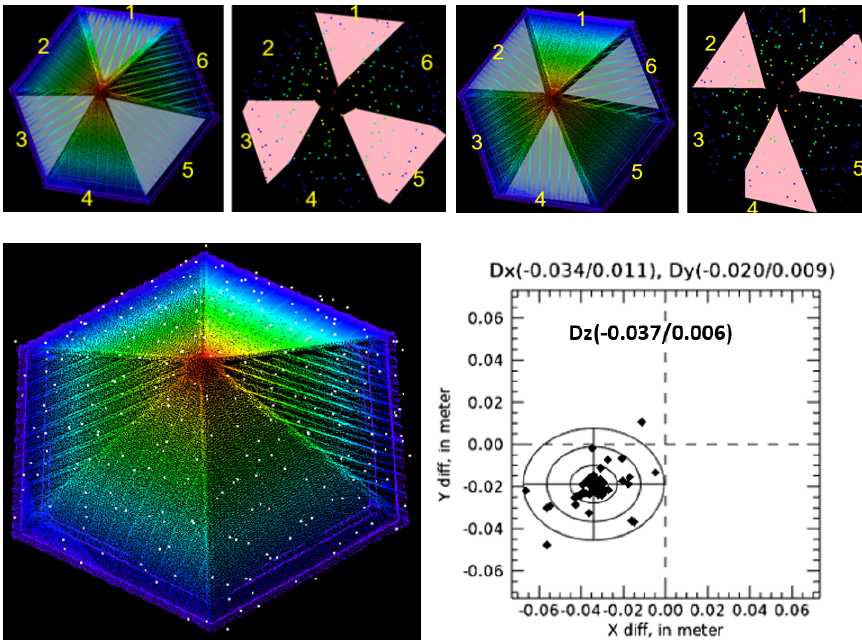
Figure 5. Geometric feature-based method, where the numbers represent plane identifier ( upper ) and two point cloud sets, and the result using the amorphous method ( lower ).